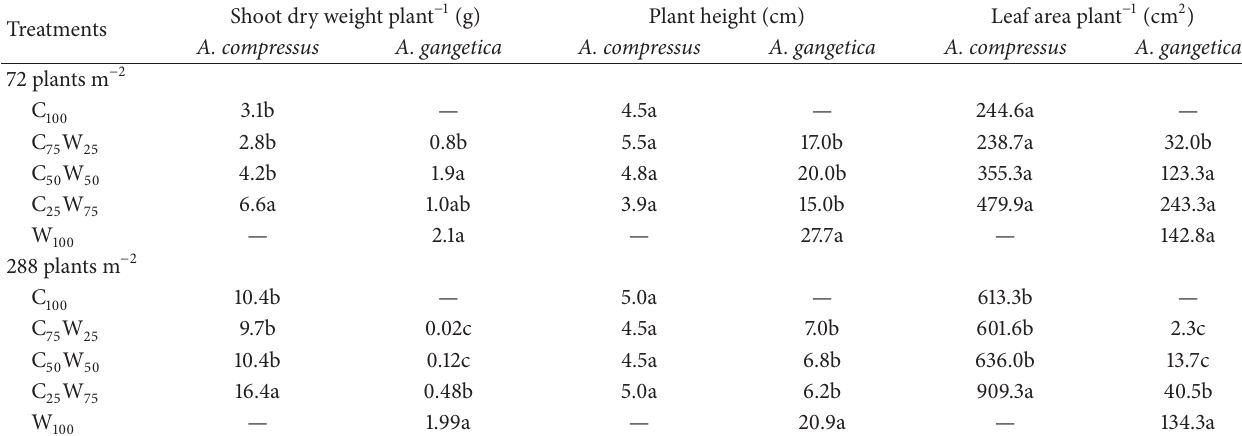
Table 1: Shoot dry weight, plant height, and leaf area of A. compressus and A. gangetica in monoculture and mixtures at 10wk after planting in full